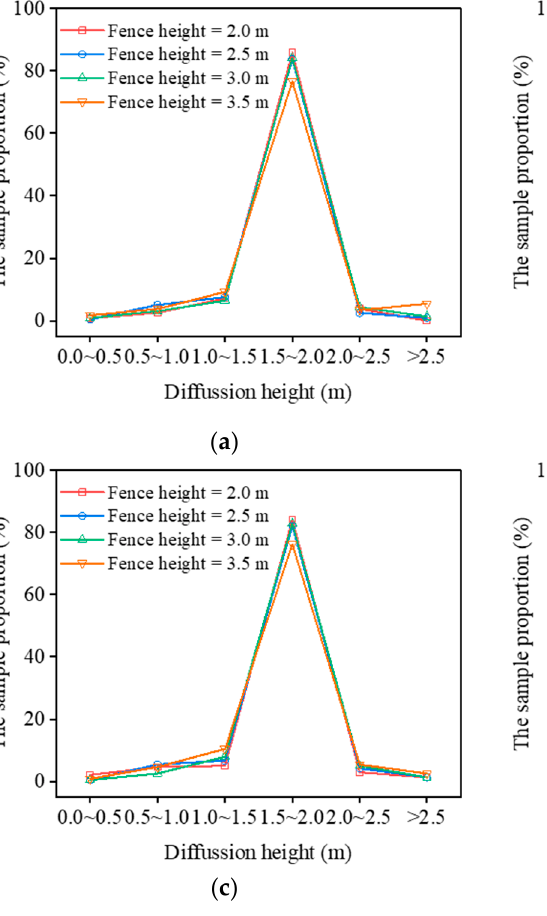
Figure 6. NPSD particle diffusion height in monitoring zone L.